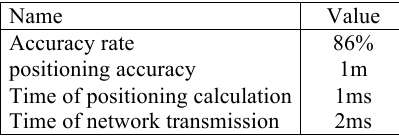
Table1. Geomagnetic positioning experiment